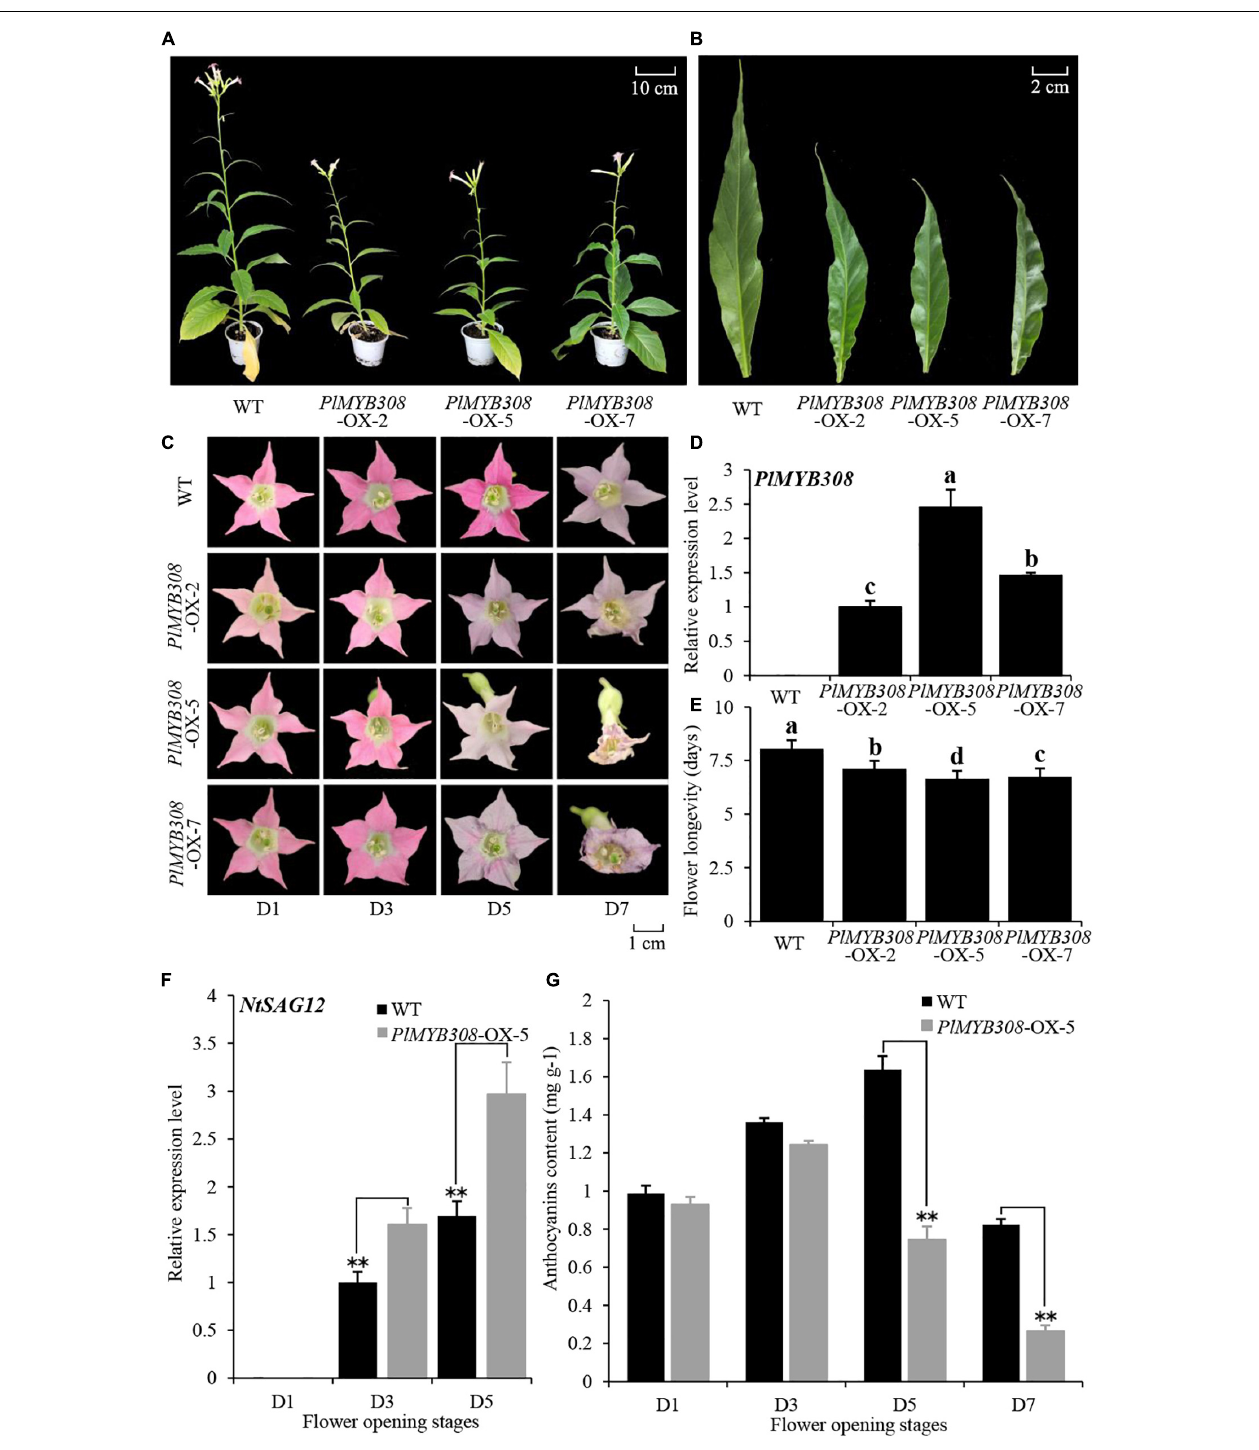
FIGURE 3 | PlMYB308 overexpression accelerated flower senescence in tobacco. (A,B) PlMYB308 overexpression led to shorter stems and smaller leaves than the wild-type (WT) control. Ten-week-old plants of WT and PlMYB308-overexpressing lines (OX-2, OX-5, and OX-7) were recorded and photographed. The fully expanded leaves were collected from the second leaves from the top of the branch. (C) The floral phenotypes were photographed at D1, D3, D5 and D7 after anthesis. (D) Expression levels of PlMYB308 in wild-type (WT) plants and PlMYB308 -overexpressing transgenic plants ( PlMYB308 -OX) by quantitative real-time PCR at D1. PlMYB308 -OX-2, PlMYB308 -OX-5 and PlMYB308 -OX-7, different lines of PlMYB308 overexpression. (E) Longevities of attached flowers in WT and PlMYB308 - overexpressing transgenic tobacco plants. Means ± SD for 10 flowers. (F) Expression levels of NtSAG12 in WT and PlMYB308-overexpressing line (OX-5) at given time points. (G) The anthocyanin content at D1, D3, D5, D7 after anthesis. Error bars show SD of the means of three biological replicates. Asterisks indicated statistically significant differences (* P < 0.05, ** P < 0.01, Student’s t -test).